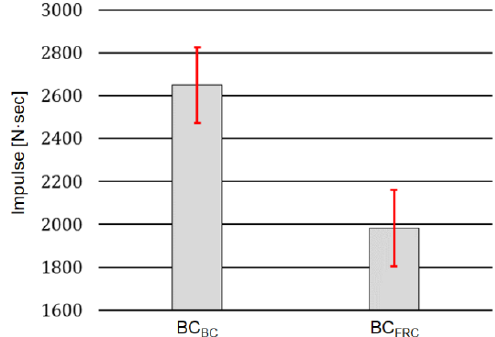
Figure 14. Mean and standard deviation values for the 10 threshold impulses observed from the robot controlled by BC BC and BC FRC. robot controlled by BC BC and BC FRC.